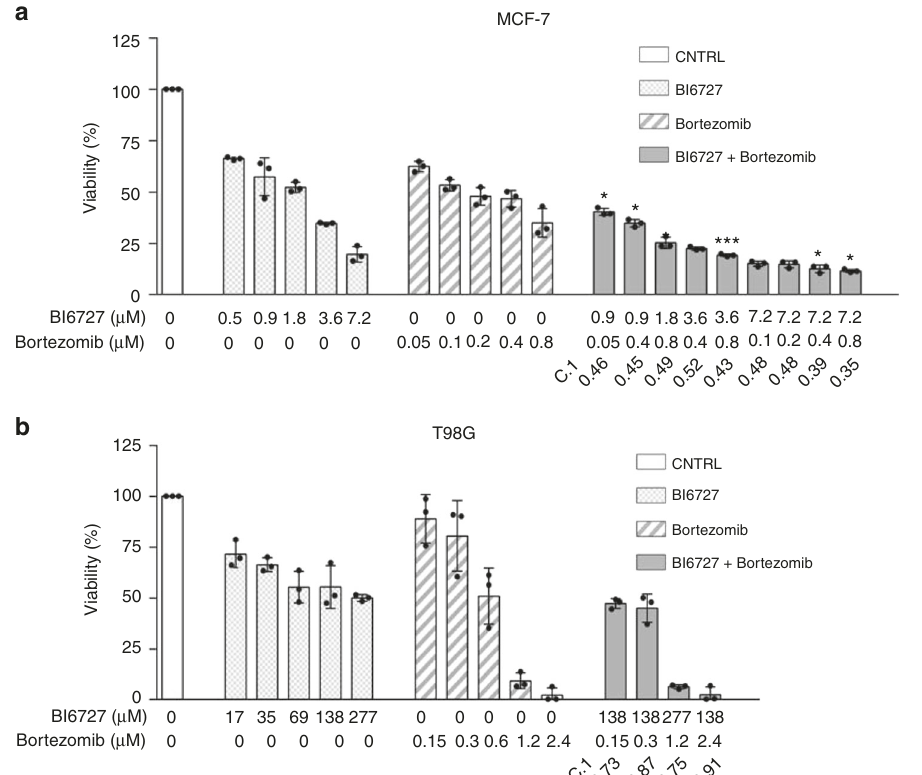
Fig. 5 Combined inhibition of PLK1 and proteasome in MCF-7 and T98G cells. MCF-7 ( a ) and T98G ( b ) cells were treated with increasing doses of Bortezomib (0.05 – 0.8 μ M for MCF-7, 0.15 – 2.4 nM for T98G) and BI6727 (0.5 – 7.2 μ M for MCF-7, 17 – 277 nM for T98G), alone or in combination, and cell viability was measured 72 h after drug administration by WST-1 assay (three independent experiments). Cell viability is represented as mean (error bars: s. d.). Statistical signi fi cance was determined by two-sided Student ’ s t test (* P < 0.05; *** P < 0.001). C.I. Combination Index (CompuSyn software). a MCF-7 cells: combinations with a C.I. lower than 0.5 are shown. b T98G cells: combinations showing synergistic effect are